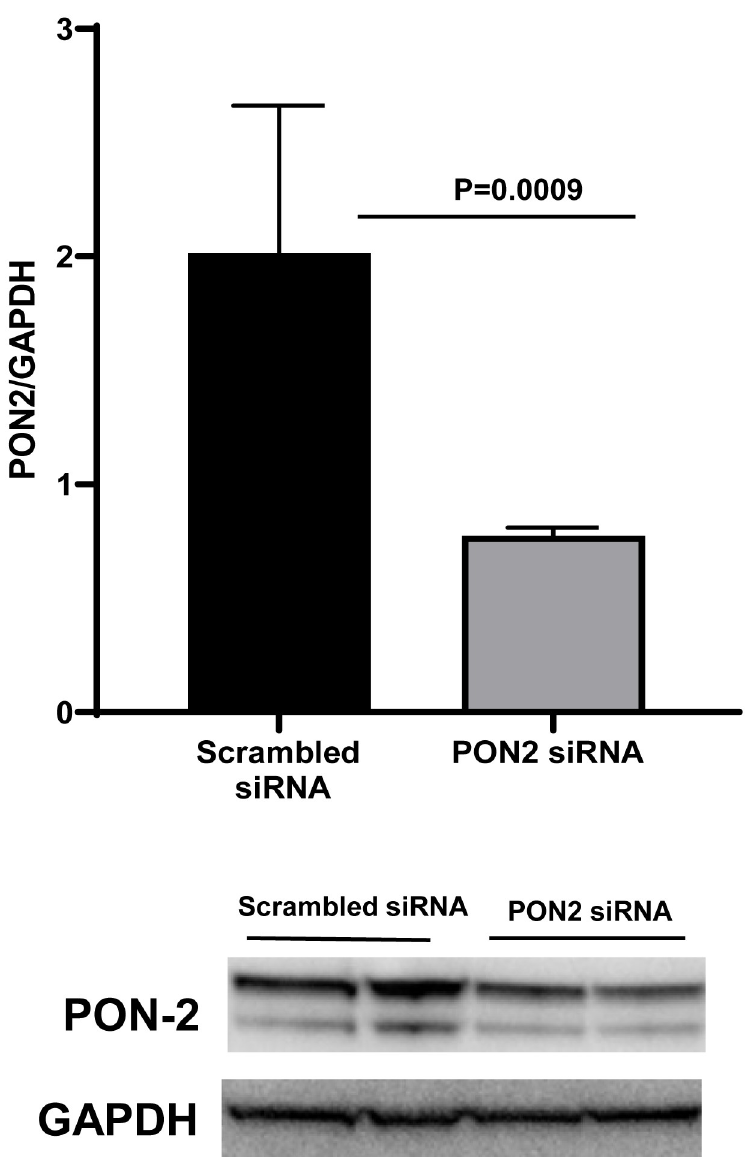
Fig 7. Paraoxonase 2(PON2) knockdown Human Bronchial Epithelial cells (BEAS-2B). At 48h post-transfection, the expression of PON2 were significantly decreased in PON2 knockdown cells. Relative quantification values were determined relative to scrambled siRNA-treated controls cells and ratio of PON2: GAPDH bands was calculated (N = 6) p < 0.0009 Unpaired t test.